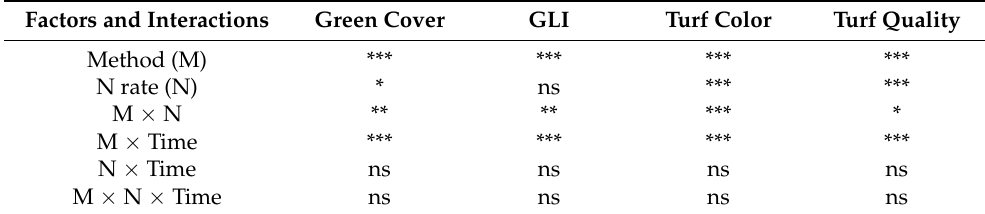
Table 1. Full model ANOVA of the effect of different suppression methods of Lolium perenne (Lp) (control, scalping, and foaming) and nitrogen applications (0, 50, 100, and 200 kg N ha − 1 application rate) on dependent variables repeated over time (green cover, green leaf index (GLI), turf color, turf quality). Factors and Interactions